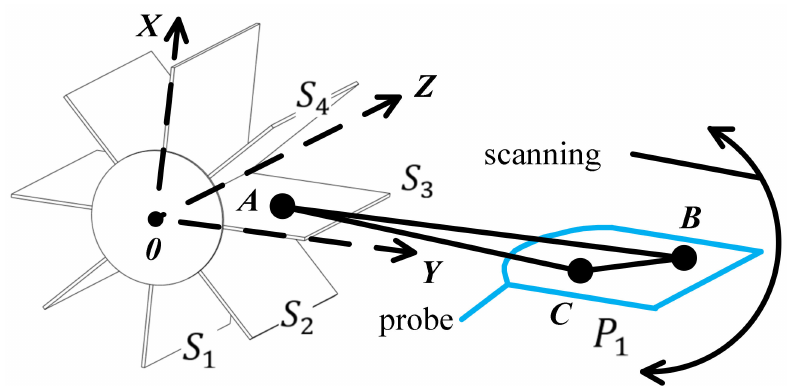
Figure 12. Probe sector synthesis in a 3D space.